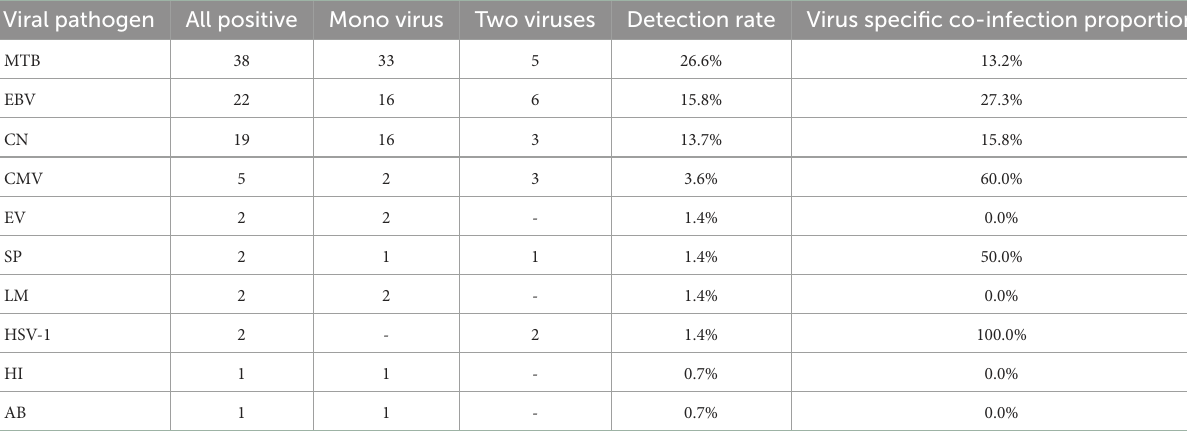
TABLE 2 The detected pathogens from suspicious ME